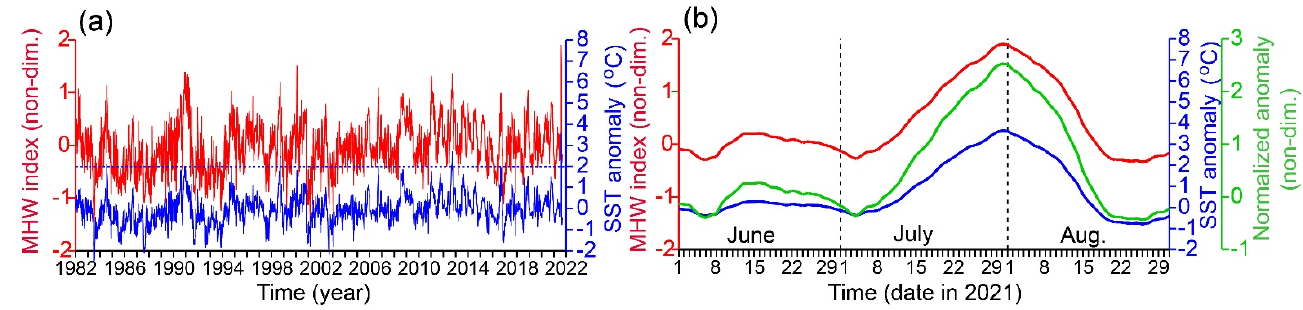
Figure 2. Time series of the daily SST anomaly (blue lines, corresponding to the right blue axes) and MHW index (red lines, corresponding to the left red axes) during ( a ) 1982–2021 and ( b ) June–August 2021. The SST anomaly and MHW index were estimated at each grid point and then spatially averaged over 143°E–180° and 40°–50°N (rectangle in Figure 1a). As indices for evaluating the variability of the daily SST anomaly, the +3 standard deviation line (dashed blue line) is shown in ( a ), and the daily SST anomaly normalized by the standard deviation at each grid point and spatially averaged over the focal area (green line, corresponding to the right green axis) is shown in ( b ).